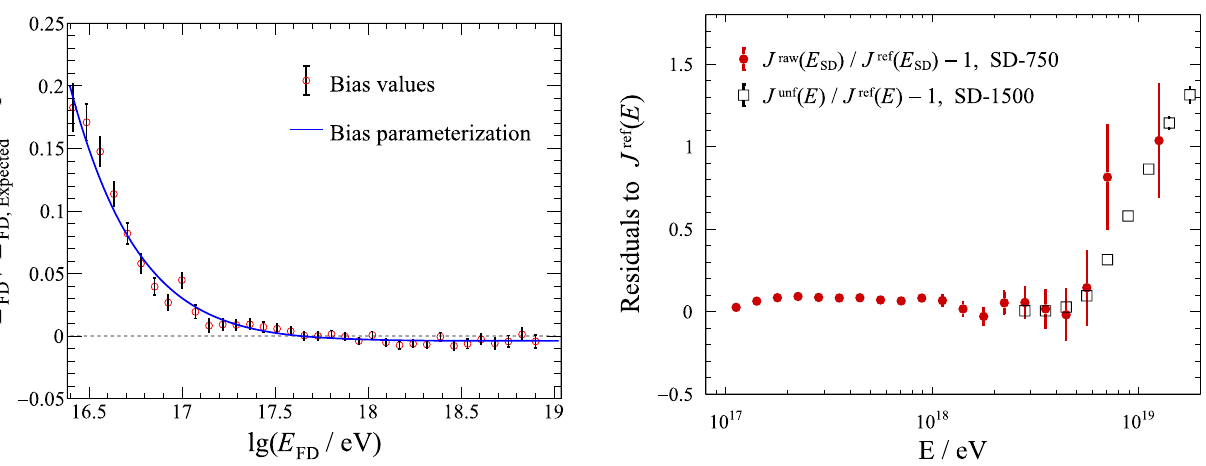
Fig. 11 Residuals of the SD-750 raw spectrum with respect to the power-law function J ref ( E ) . Data points from the SD-1500 spectrum measurement are